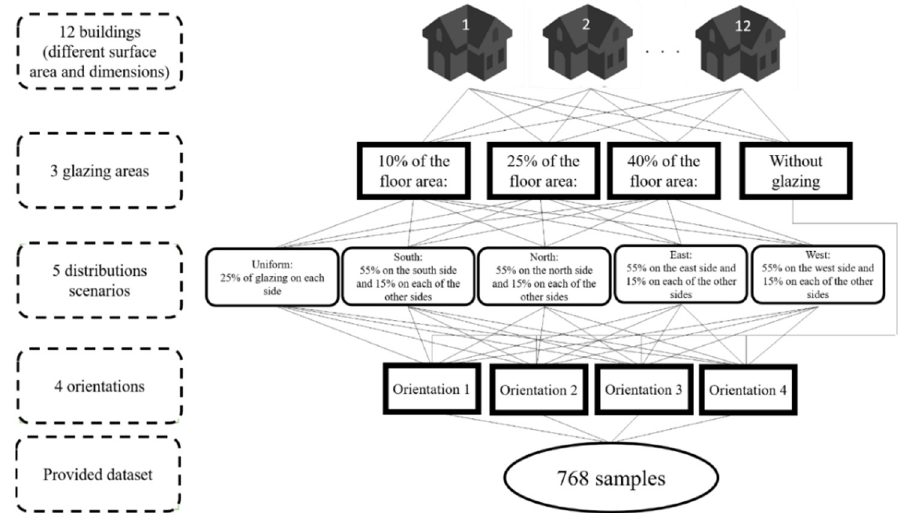
Figure 1. Graphical view of data preparation.